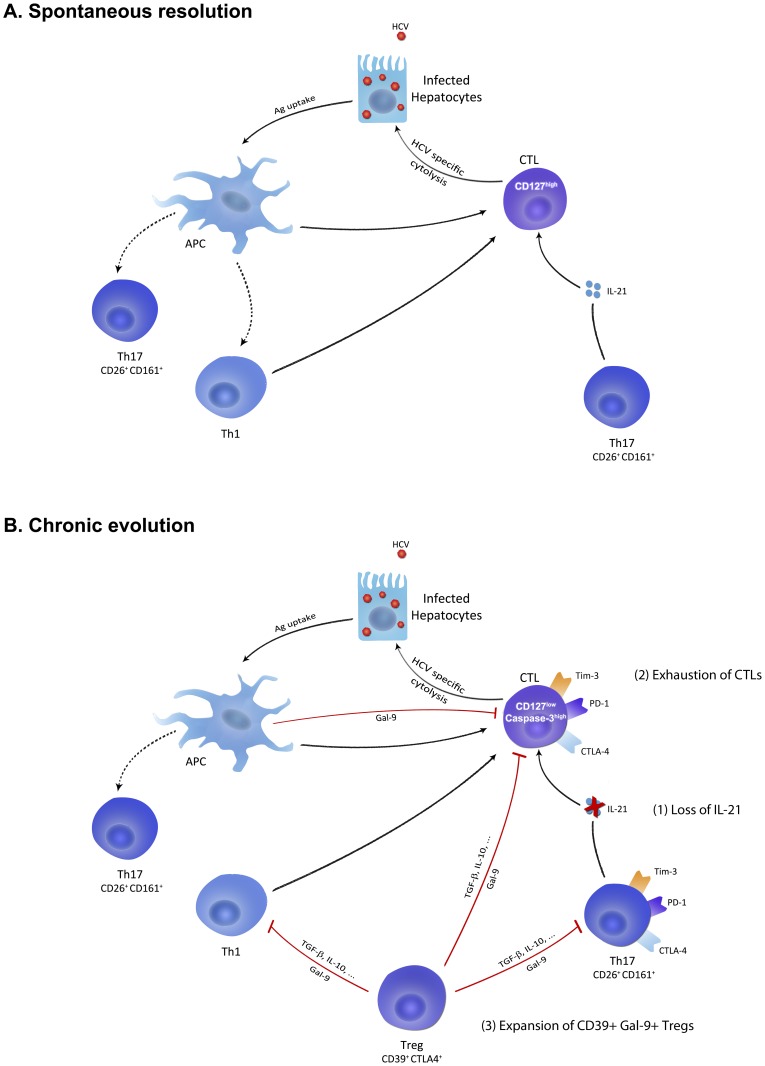
Proposed model for role of Galectin-9 and IL-21 during acute HCV infection.(A) HCV infection of hepatocytes and antigen uptake and presentation by liver-resident and circulating antigen presenting cells (APCS) prime HCV-specific CTLs and helper CD4 T cells including Th1 and Th17 cells. Function and survival of HCV-specific CTLs are sustained by increased production of IL-21 by Th17 cells during the late acute phase of spontaneously resolving HCV infection. (B) In patients with chronic evolution, multiple inhibitory mechanisms cooperate to induce failure of the immune response and facilitate viral persistence. (1) HCV-specific Th17 cells produce less IL-21 thus compromising CTL survival and function. (2) HCV-specific CTLs become exhausted and up-regulate exhaustion molecules like Tim-3, PD-1 and CTLA-4 and become more susceptible to apoptosis that is aggravated by lack of sufficient IL-21. (3) CD39+ Tregs are increased in frequency and may directly inhibit Th17 cells and Tim-3-expressing CTLs via Gal-9-mediated apoptosis or through classical mechanisms including cellular contact and immuno-modulatory cytokines like IL-10 and TGF-β.